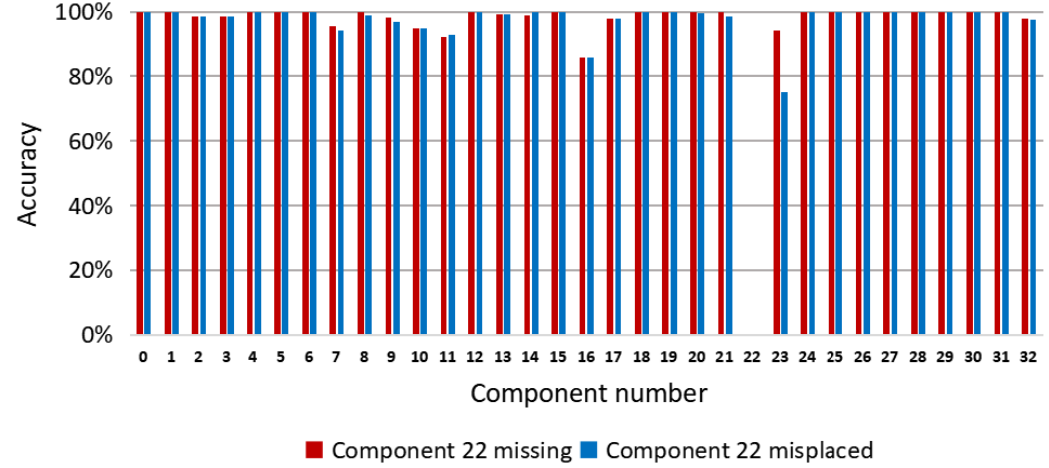
Figure 13. Pixel classification accuracy of each component on PCBs with component 22 missing and misplaced, which is calculated based on the color-labeled image of the correctly mounted PCB.